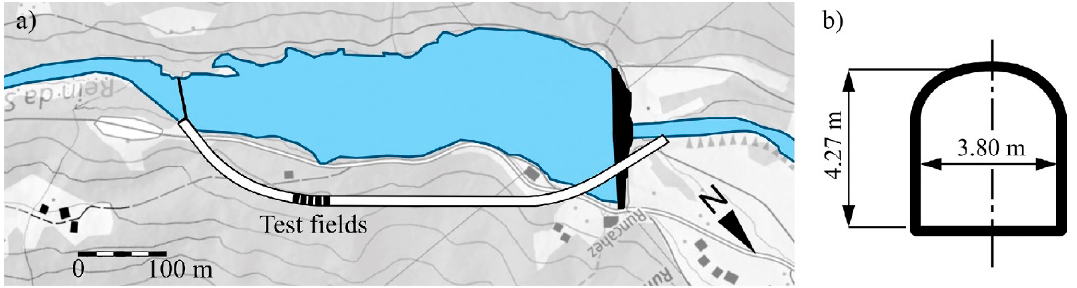
Figure 3. ( a ) Overview and ( b ) cross section of the Runcahez SBT (position 46°40’45.0” N 8°58’05.7” E; adapted from [18] ).